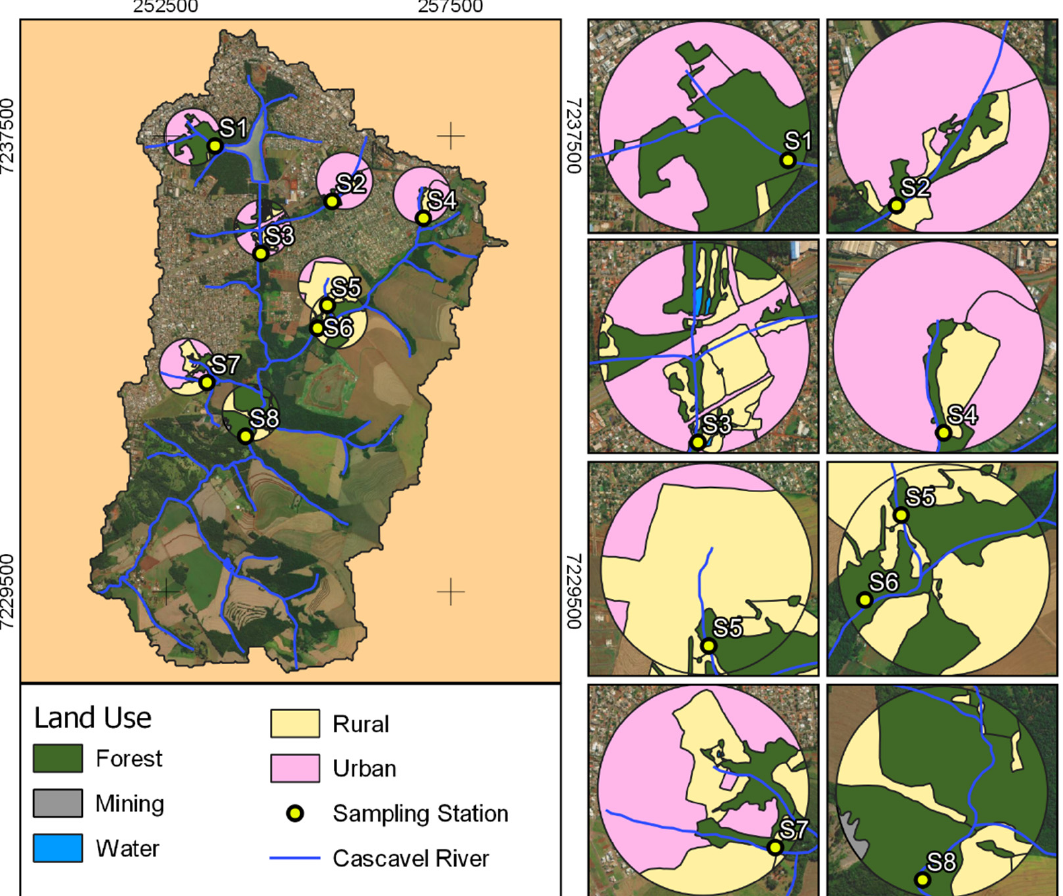
Figure 2. Area of influence containing detailed land use, and sampling stations following the upstream-downstream flow, with a diameter of 1 km.